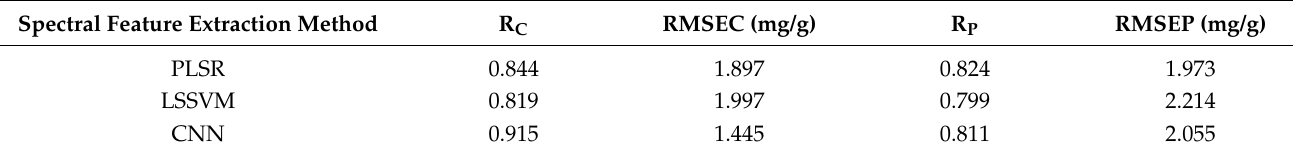
Table 4. Comparative analysis of different modeling